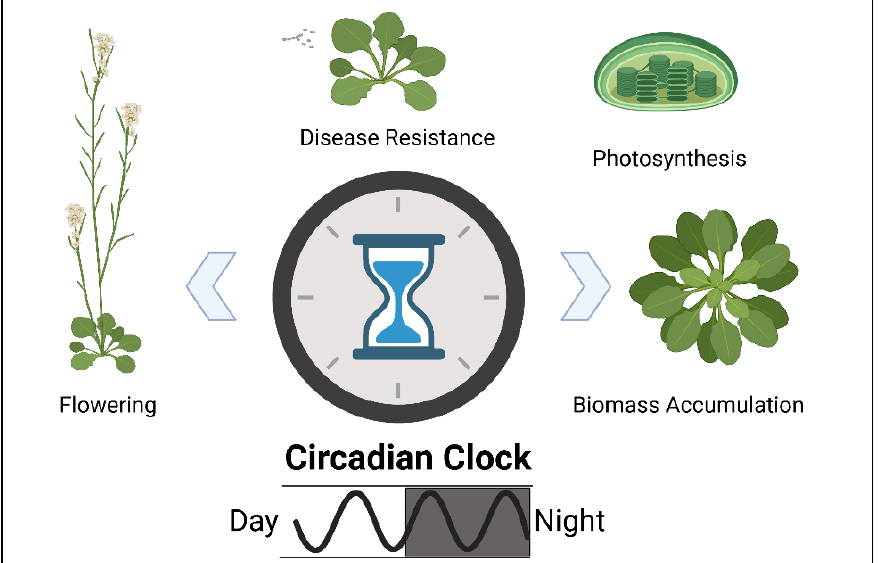
Figure 4. Various plant processes affected by Circadian rhythm defining overall fitness.